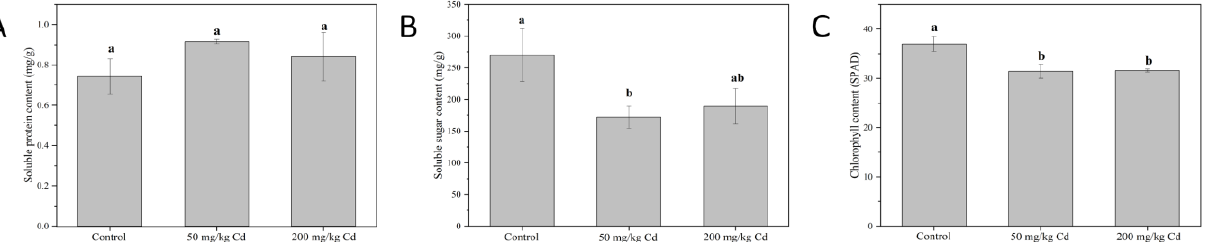
Figure 2. The content of soluble protein ( A ), soluble sugar ( B ), and chlorophyll ( C ) of muskmelon plants in different Cd concentration treatment groups. The data show the means ± SD of three replicates. Different lowercase letters indicate significant differences at p < 0.05.